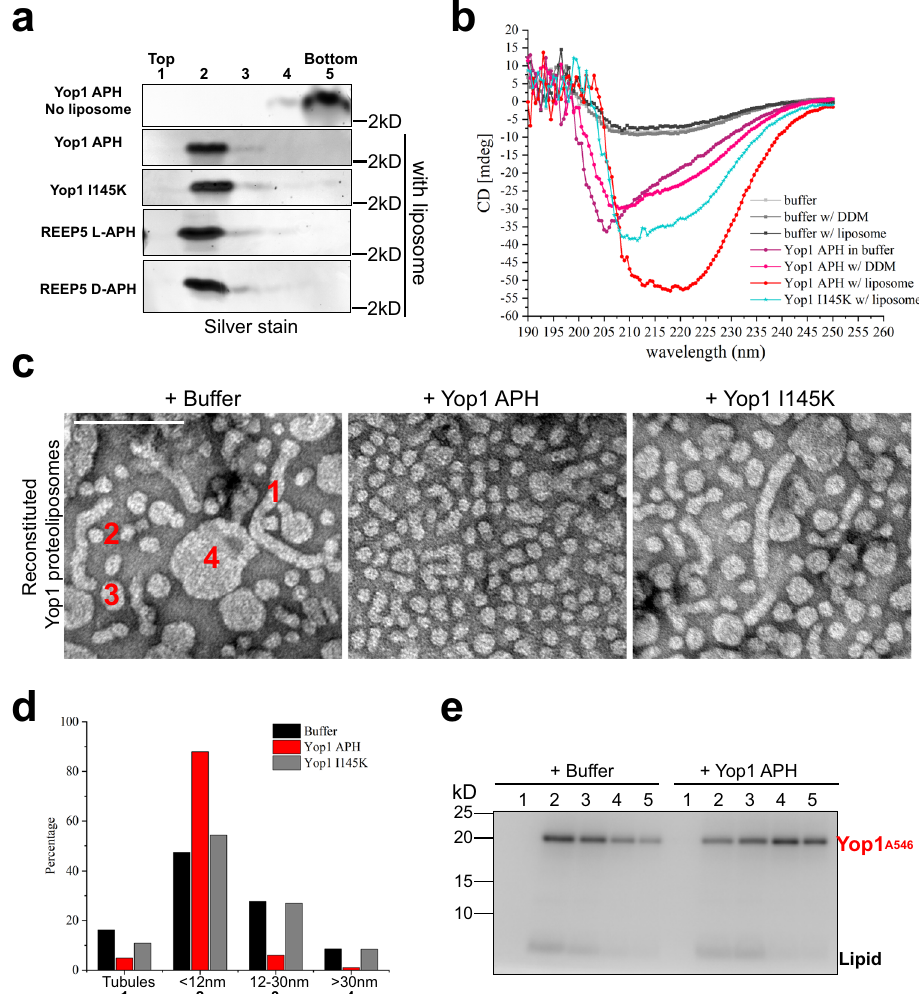
Fig. 6 Synthetic APH peptides bind to liposomes and generate high curvature. a Peptides corresponding to the APH of wild-type Yop1, to APH harboring a point mutation (Yop1 I145K), or to the APH of REEP5, with either L- or D-amino acids (REEP5 L-APH and REEP5 D-APH), were incubated with liposomes containing S. cerevisiae lipids at a 1:40 molar ratio of peptide to lipid. The samples were subjected to fl otation in a Nycodenz gradient and analyzed by silver staining. The experiment was performed two times. The sequences of the peptides are shown in Supplementary Table 3. b The indicated peptides were analyzed by CD spectroscopy in the buffer, DDM, or after incubation with liposomes. The experiment was performed two times. c Yop1 was reconstituted into proteoliposomes and incubated with the indicated peptides. The samples were analyzed by negative-stain EM. Bar, 100 nm. d Quanti fi cation of the structures seen in c . Short tubules (1), vesicles with diameters <12 nm (2), vesicles with diameters 12 – 30 nm (3), and vesicles with diameter >30 nm (4) were counted ( n = 1662 for a buffer, 1490 for Yop1 APH, and 1800 for Yop1 I145K from two independent experiments). e Alexa 546-labeled Yop1 (Yop1 A546 ) was reconstituted into liposomes containing S. cerevisiae lipids at a molar ratio of 1:200 protein to lipid. The samples were incubated with buffer or Yop1 peptide (1:20 molar ratio of peptide to lipid) and subjected to fl otation in a Nycodenz gradient. Fractions were analyzed with a fl uorescence scanner. The lower band corresponds to lipid. The experiment was performed three